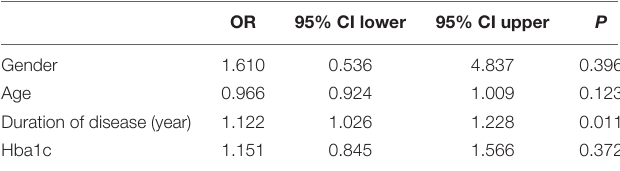
TABLE 4 | Risk factors for CAN in TIDM patients. TABLE 5 | Risk factors for CAN in T2DM